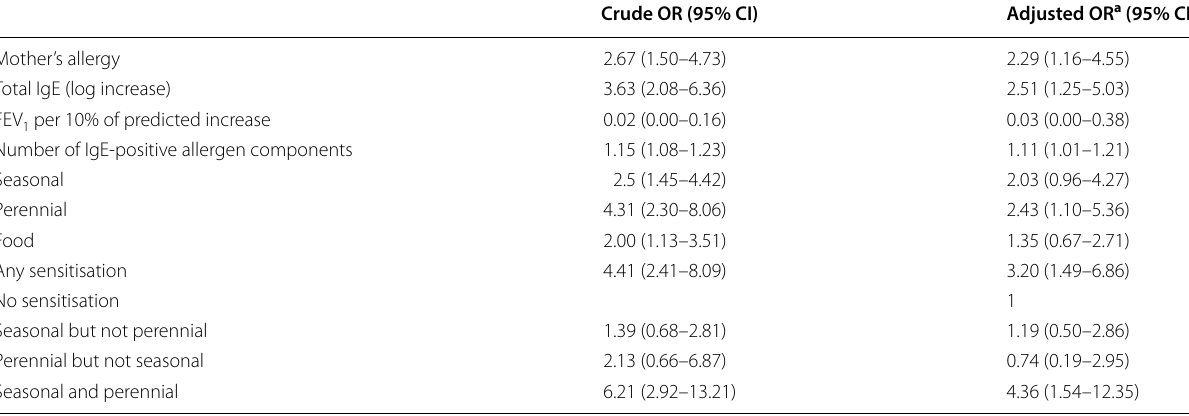
(OR (95% CI) odds ratio (95% CI) a Adjusted for gender, age, mother’s allergy, total IgE, BMI and FEV